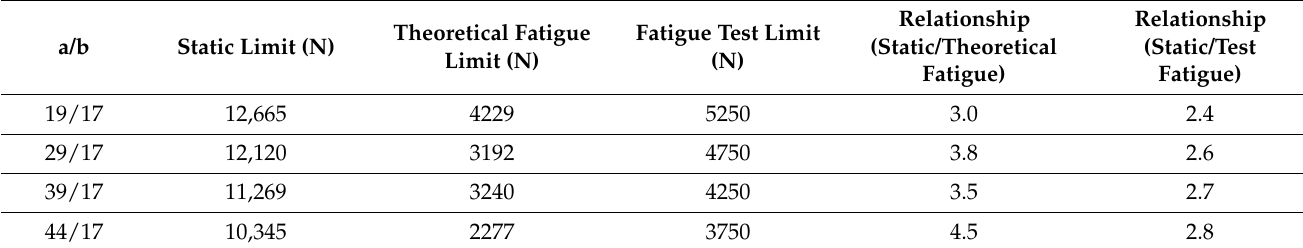
Table 3. Maximum static load, theoretical fatigue limit and test fatigue limit for the different clamps tested where (a) is the front clamp lever and (b) rear clamp